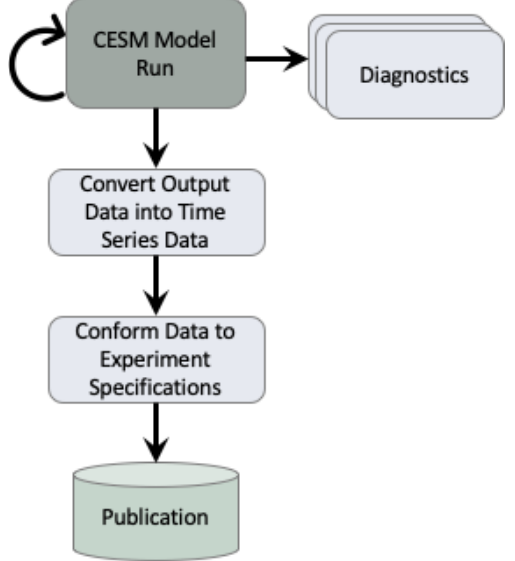
Figure 1. This flowchart describes the tasks that are executed within the CESM workflow in order to generate data for CMIP. The diag- nostics task can be executed several times while the CESM model run is executed. The remainder of the tasks are each executed once when the CESM model run completes. This flow chart is a simplis- tic view of our general workflows. In practice, our workflows are more similar to the workflow depicted in Appendix Fig.